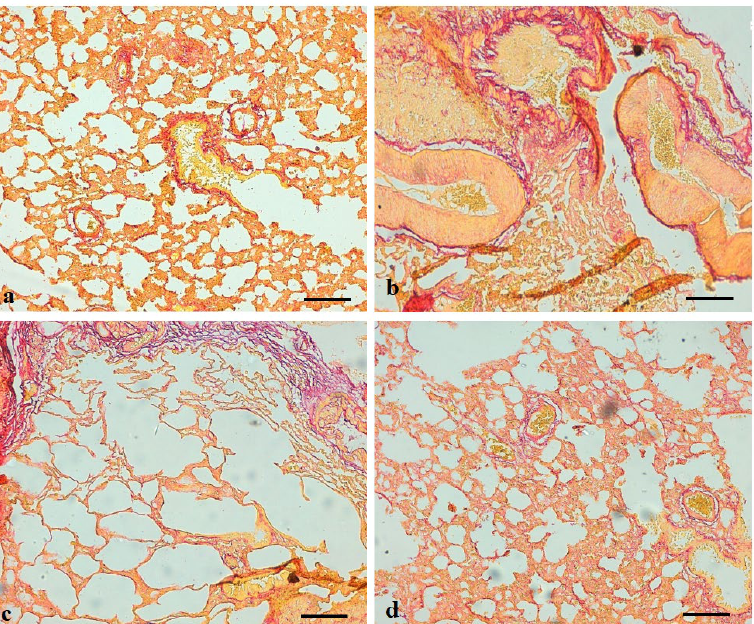
Figure 9. Effect of ADE on lung fibrosis ( a ) in control group, normal fiber was seen; ( b ) B(a)P-treated group showed thick fiber deposition ( c ) ADE + B(a)P treatment group show low fiber deposition ( d ) in ADE-only-treated group, normal fiber was seen (Scale bar = 100 µm).